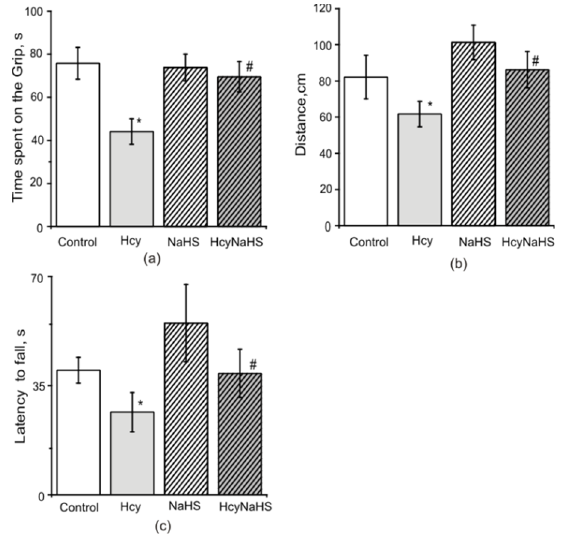
Figure 4. Effects of maternal hHcy and NaHS treatment on muscle endurance and motor coordination. The time spent on the grid (before falling) in paw grip endurance (PaGE) test ( a ), distance ( b ) and latency to fall ( c ) in Rotarod test of rats compared to control (white columns), Hcy (grey columns), NaHS (dashed columns), HcyNaHS (grey dashed columns) groups. * p < 0.05 compared to the control group, # p < 0.05 compared to the Hcy group.